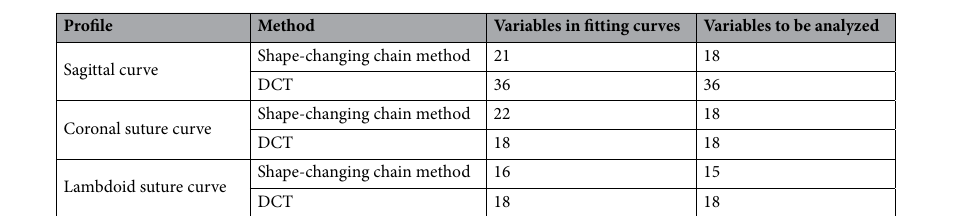
Table 5. Numbers of variables used in the shape-changing chain method and in DCT 33 for fitting and analyzing suture